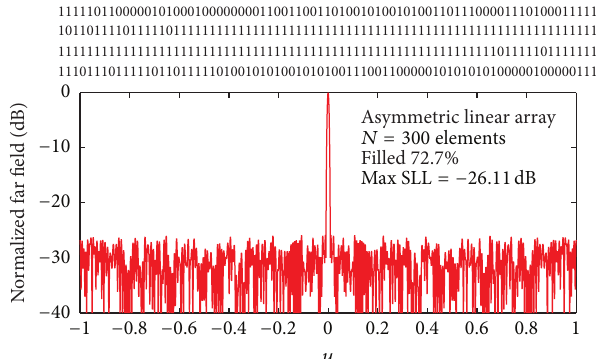
Figure 4: Radiation pattern of the best obtained array for the 300- element symmetric thinned array with same aperture length. Table 5: Comparative results for 300-element asymmetric thinned array. The smaller values are in bold.